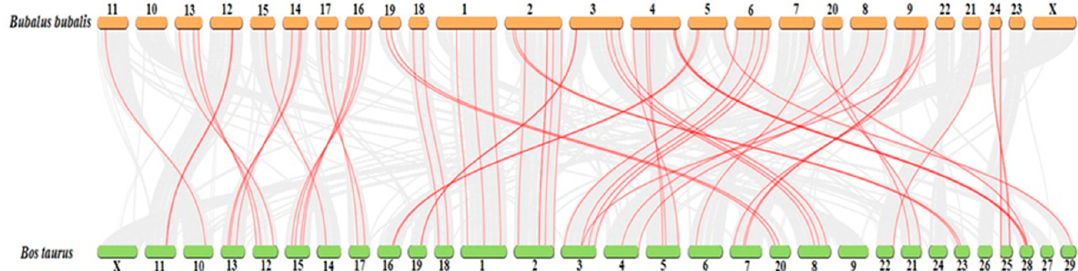
Figure 4. Collinearity analysis showing distribution of HSP genes in buffalo and cattle.